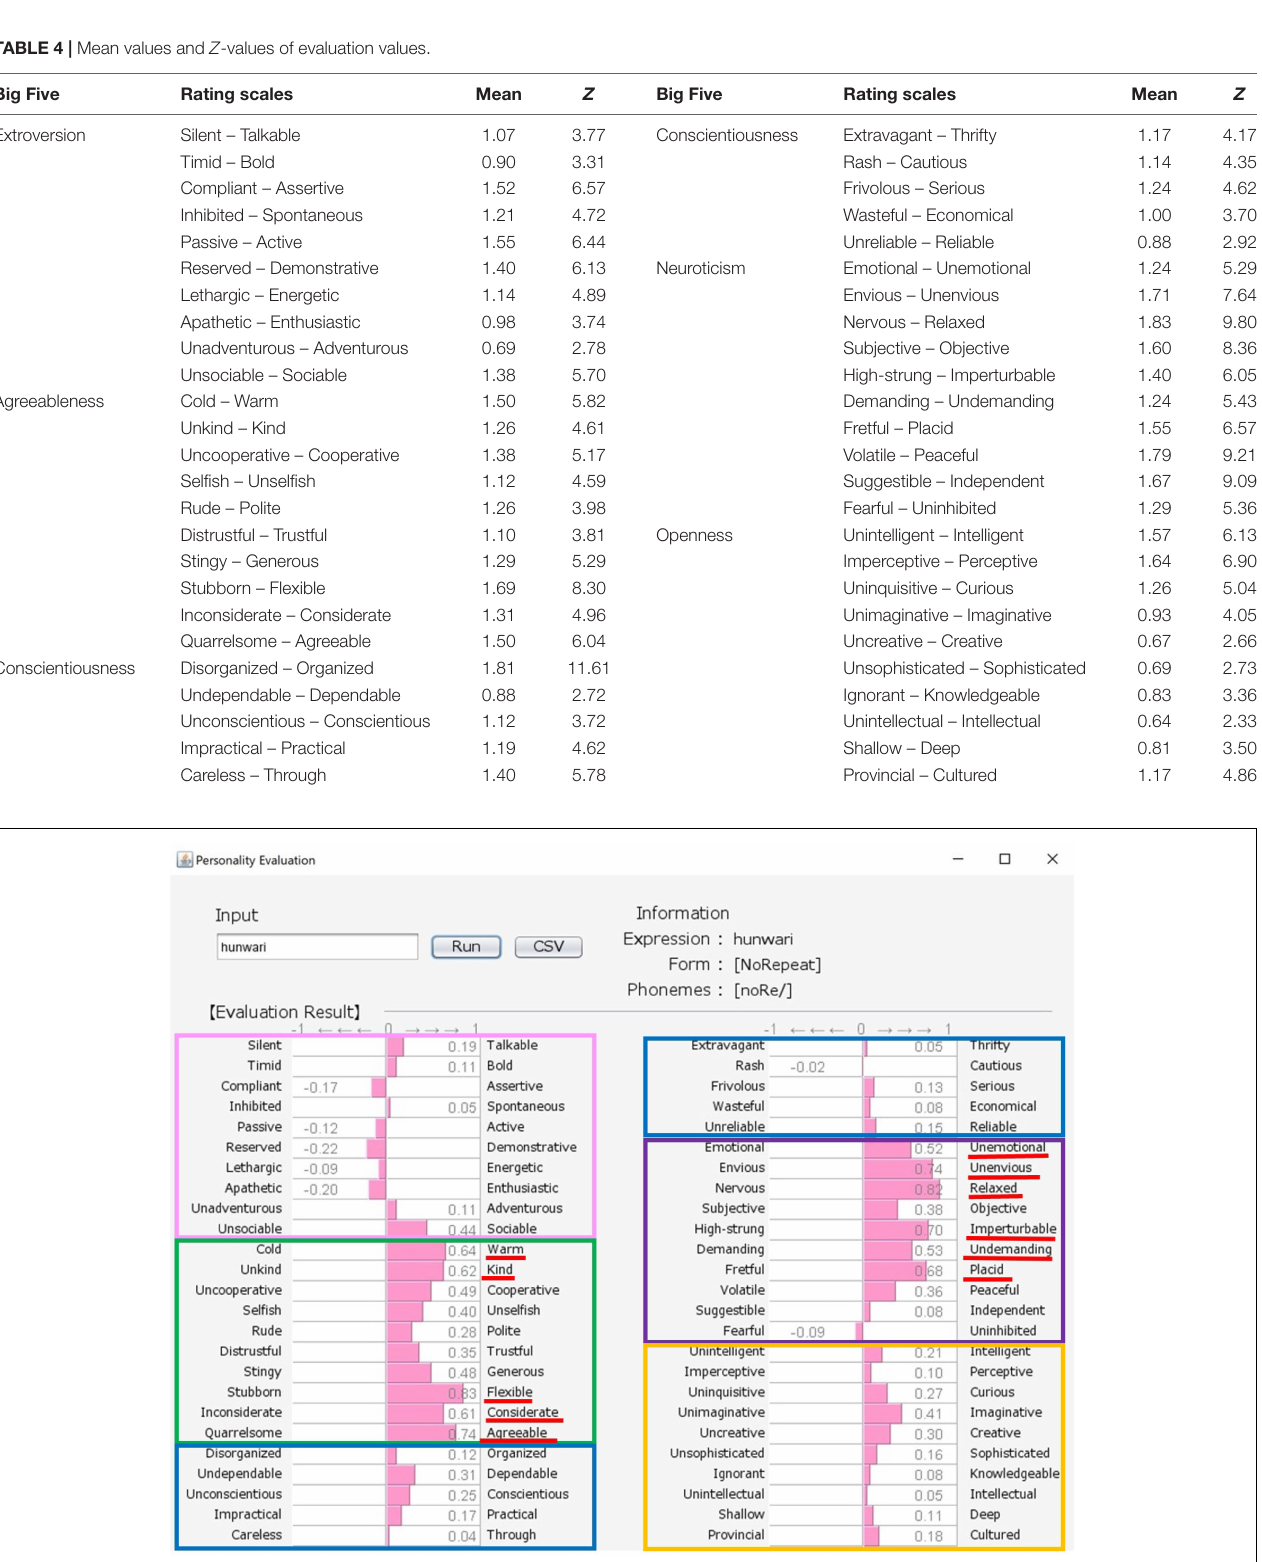
FIGURE 4 | Output for “hunwari (gentle)” personality. The pink, green, blue, purple, and orange frames indicate Extroversion, Agreeableness, Conscientiousness, Neuroticism, and Openness, respectively.